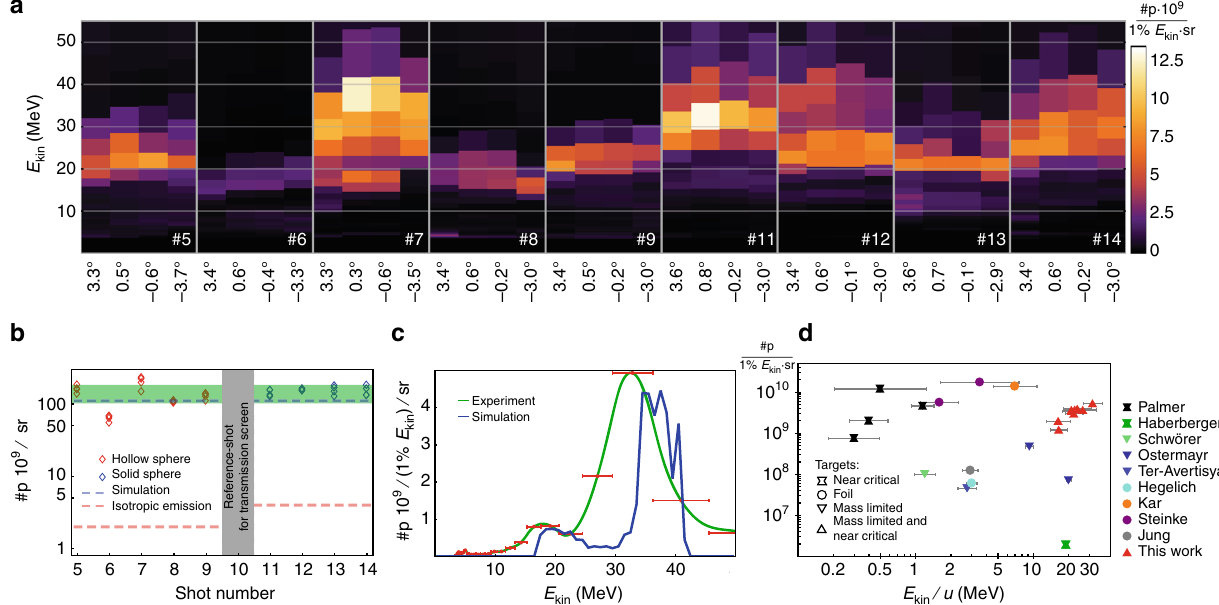
Fig. 2 Experimental results. a Differential proton spectra for consecutive laser shots for various angles. b Proton number per solid angle from experiment compared to isotropic emission into 4 π and numerical simulation, the green area represents the standard deviation of the experimental data. c Comparison of simulated differential proton spectrum and experiment (shot 11@0.8°), the red error bars indicate the spectrometer resolution. d Summary of differential ion yields for experiments reporting on narrow energy spread, represented by the horizontal error bars (FWHM). Cross-shaped symbols represent results obtained with CO 2 -laser pulses in gaseous plasmas with critical density, circles represent results from thin foils, and triangles pointing down spherical solid targets (such as droplets). See Refs. 6 –